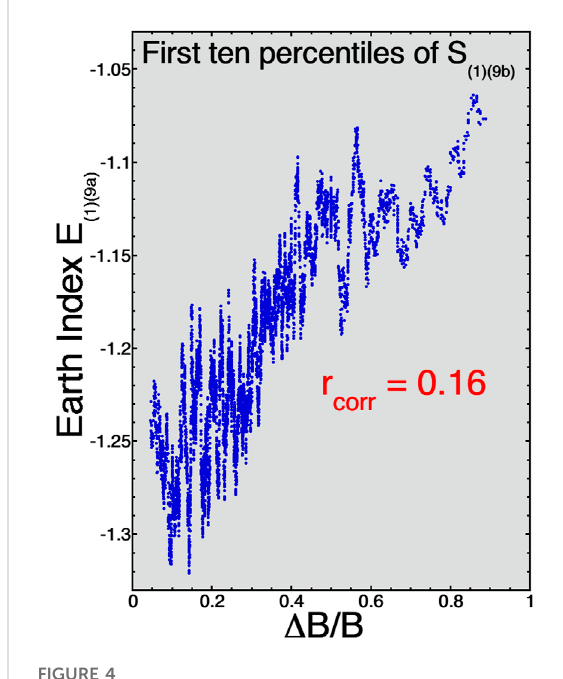
FIGURE 4 For times when the solar-wind composite driver function S (1)(9b) is in its lowest 10% of values, a 101-point running average of the Earth index E (1)(9a) is plotted as a function the upstream fl uctuation amplitude Δ B/B.